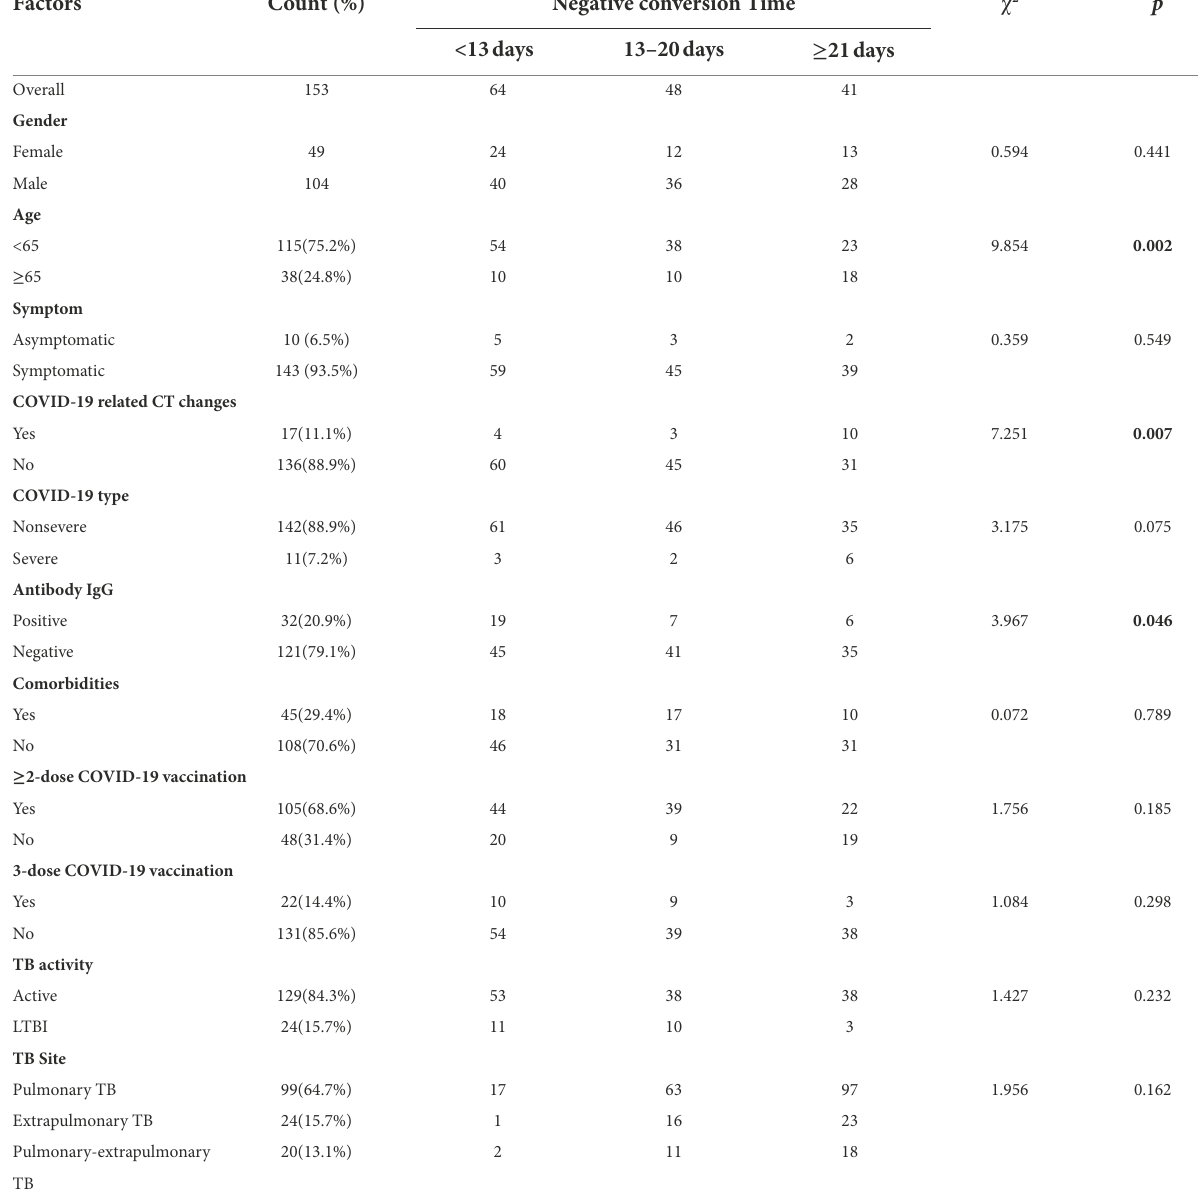
TABLE 1 The duration of SARS-CoV-2 clearance in 153 COVID-19 and TB coinfection